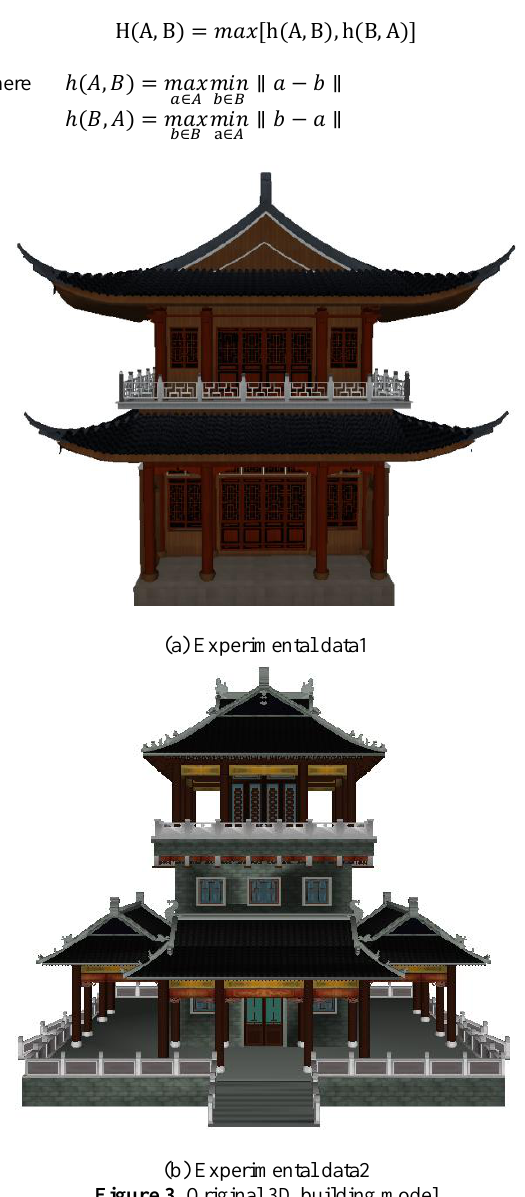
Figure 3 . Original 3D building